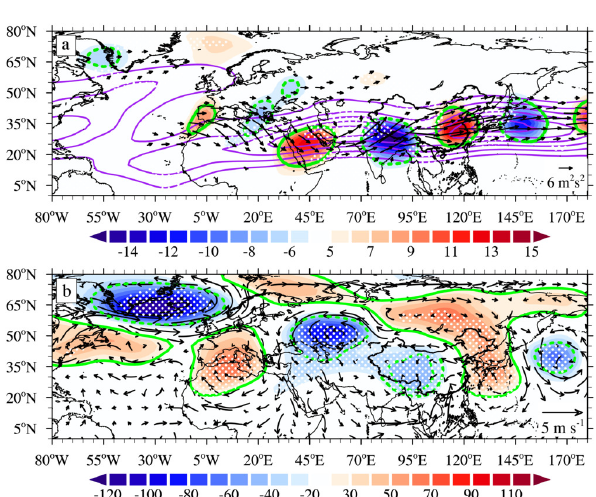
Figure 14. As Fig. 4 but for the six south rainfall–no north haze (SR–noNH) events in Table